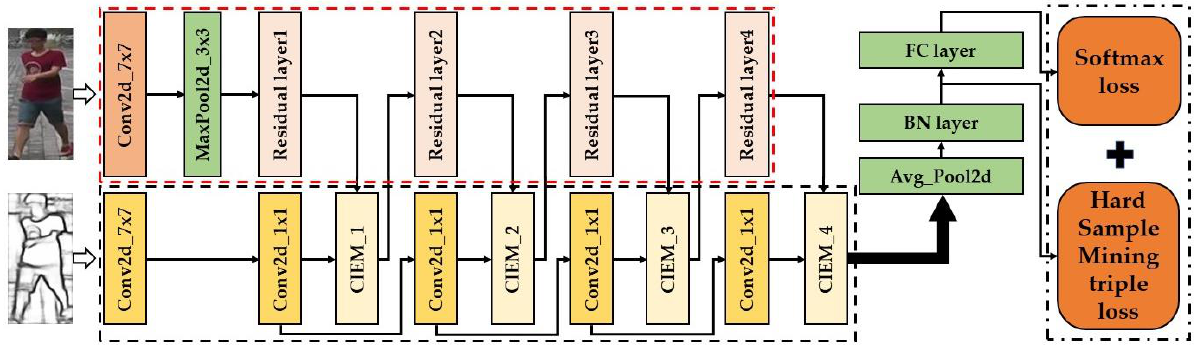
Figure 2. Structure diagram of contour information extraction module. Dimension raising and dimension reducing in the figure are omitted.